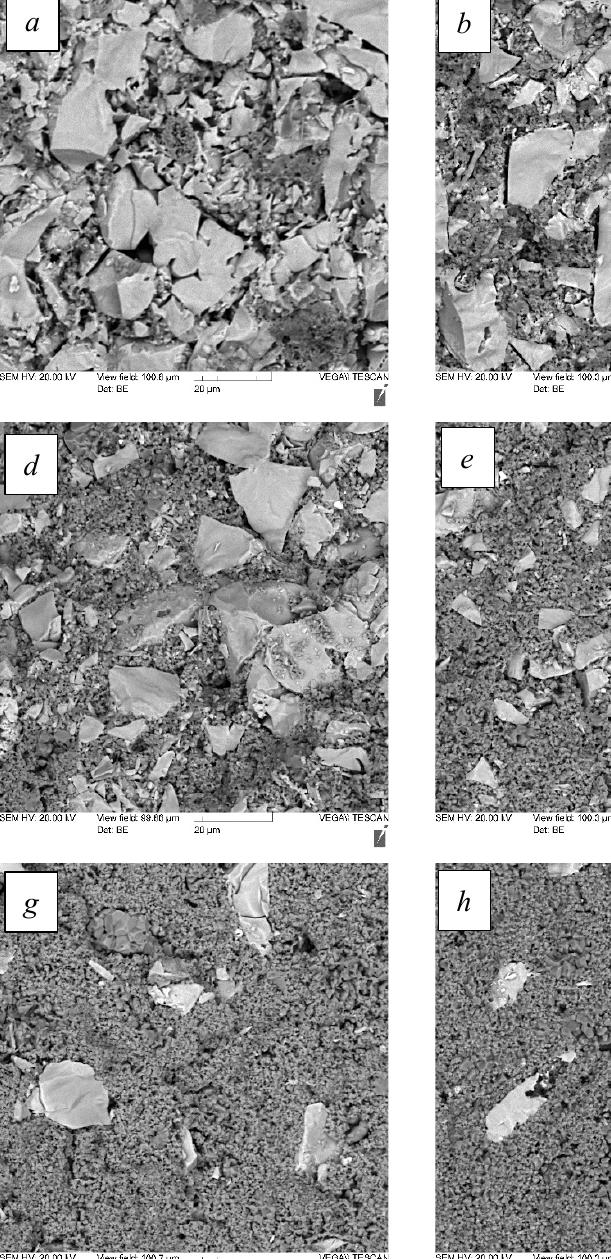
Figure 2. SEM images of (100 − x) wt.% BCZT + x wt.% NCCMF composite ceramics, ( a ) x = 20, ( b ) x = 30, ( c ) x = 40, ( d ) x = 50, ( e ) x = 60, ( f ) x = 70, ( g ) x = 80, ( h ) x = 90.